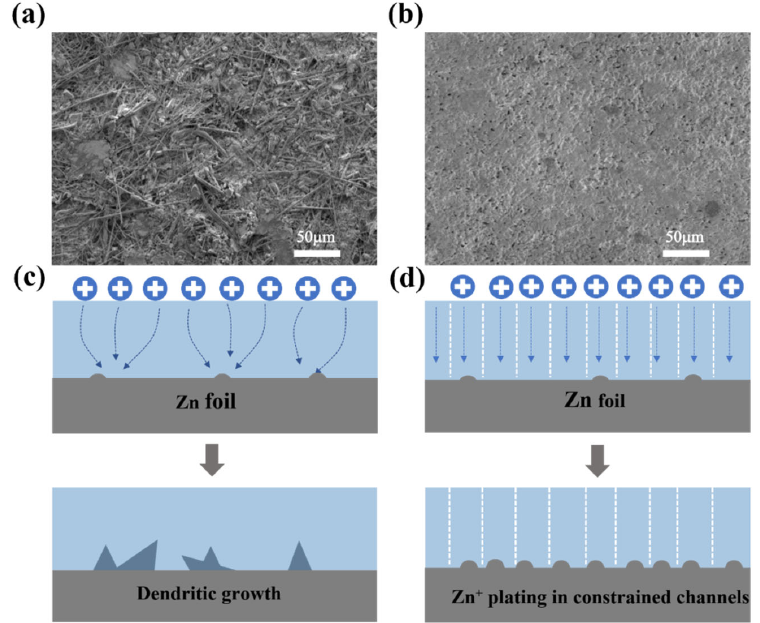
Figure 9. The surface morphology of Zn after 500 h in ( a ) Zn/LE/Zn and ( b ) Zn/GPE/Zn batteries, respectively. The mechanism for the deposition behaviors of Zn in ( c ) LE and ( d ) GPE.